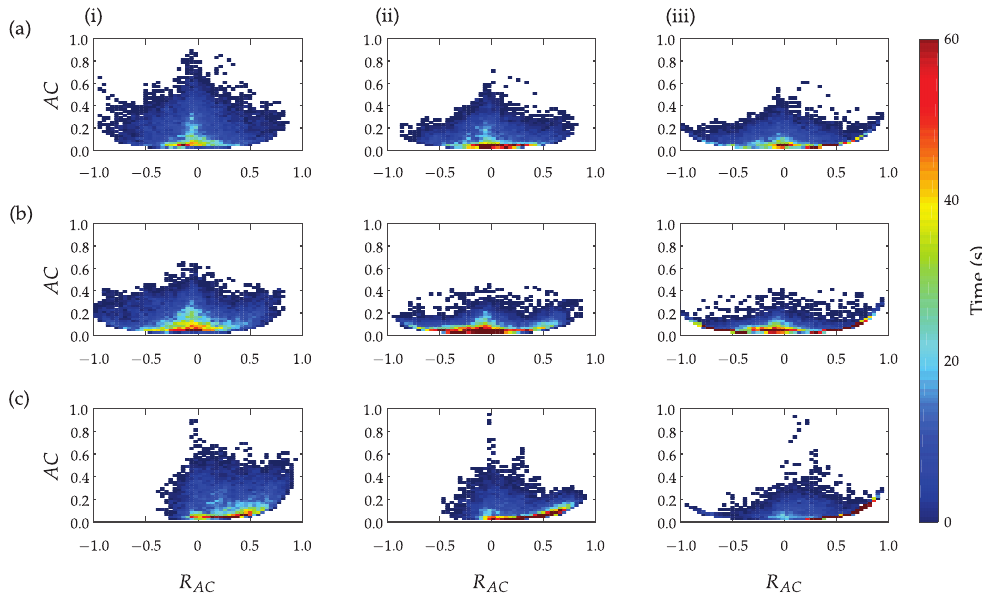
Figure 8. Upper limb activity counts AC in relation to R AC computed from accelerations ( i ), from accelerations with subtracted gravitational acceleration g ( ii ), and from accelerations with subtracted trunk acceleration ( iii ) for a healthy person ( a ) and two patients after stroke ( b , c